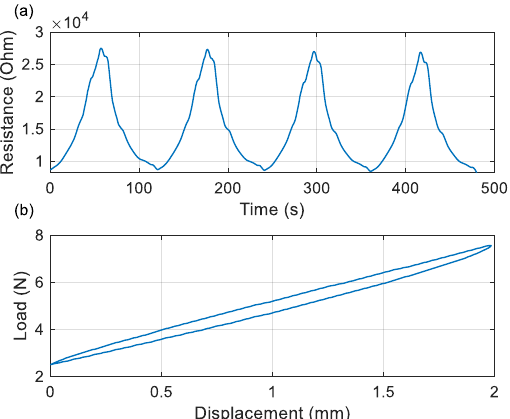
Figure 5. Strain and resistance (at 1 Hz) relationship achieved from AC admittance test.